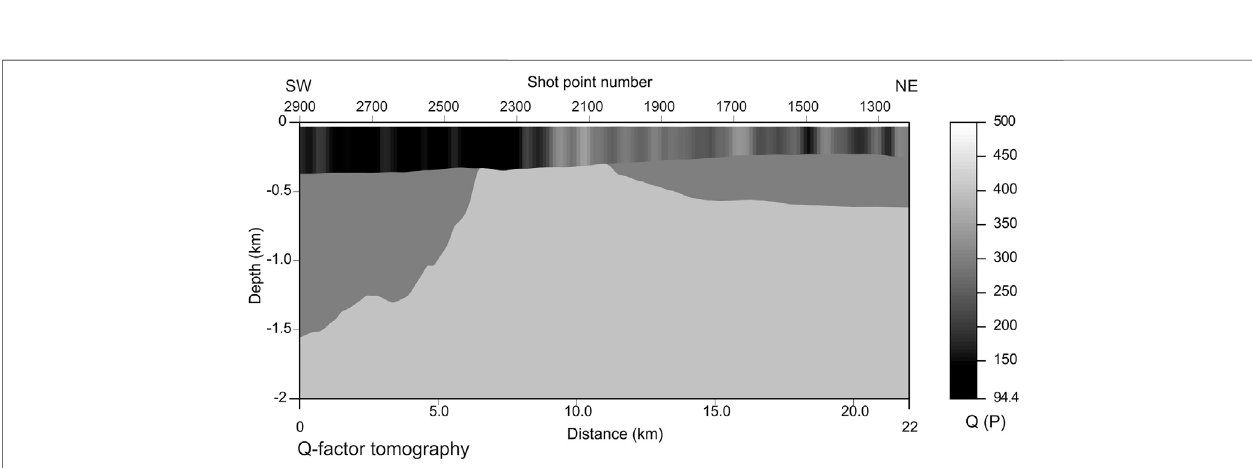
FIGURE15| QfactorestimationobtainedbyPvelocityin Figure7 andtheanelasticabsorptioncoef fi cientin Figure8 .Thisresultisthelow-frequencycomponent, based on tomography only.